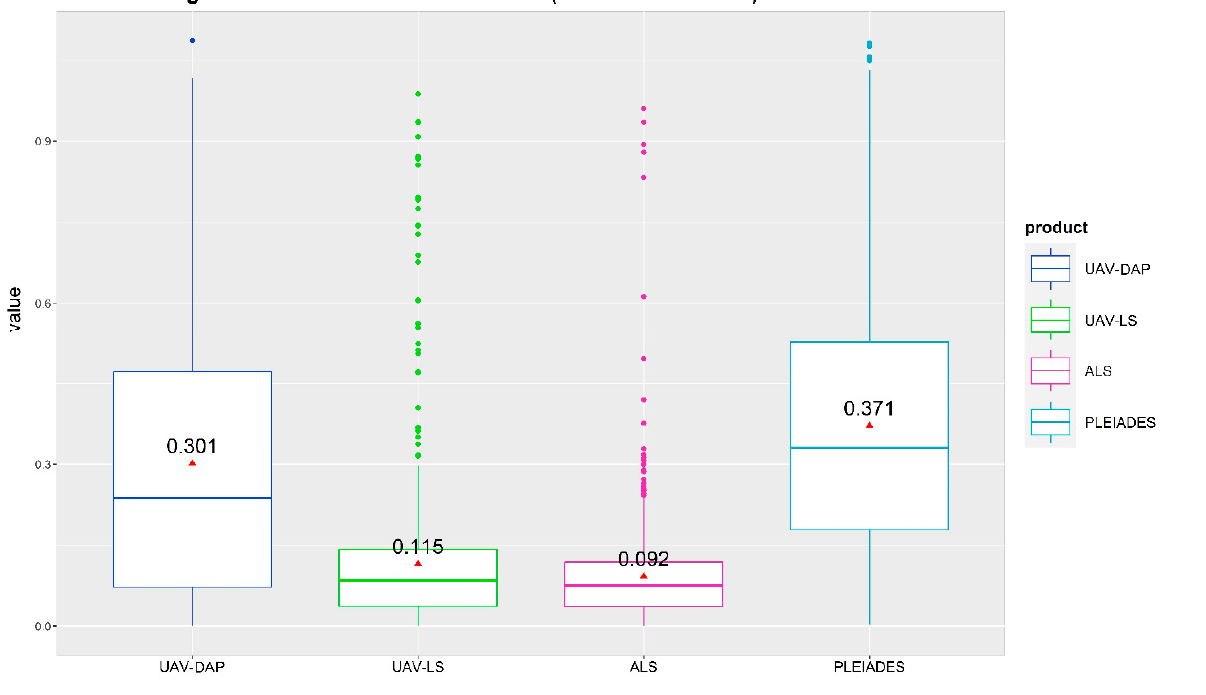
Figure 8. Accuracy of DTMs generated from data from different platforms and sensors: unmanned aerial vehicle (UAV-LiDAR and UAV-DAP), aircraft (ALS), and Pléiades satellite (DAP–RGB im- ages).